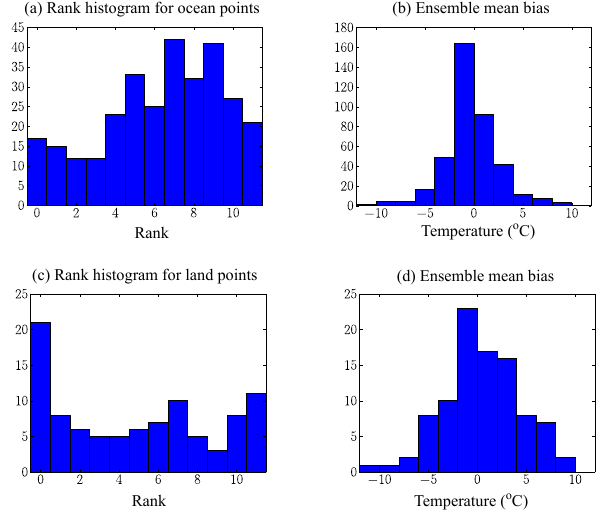
Fig. 4. Rank histograms and mean bias histograms for the LGM anomaly, considering the ocean and land